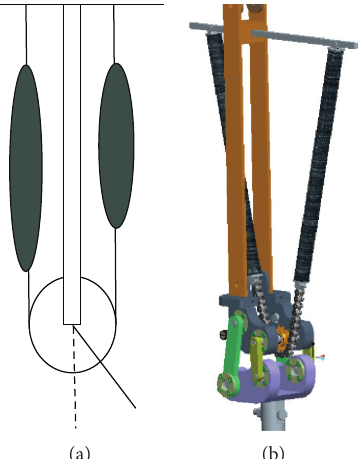
Figure 2: Driving principle: (a) the way of joint driven by PAM and (b) the installation location of PAM.